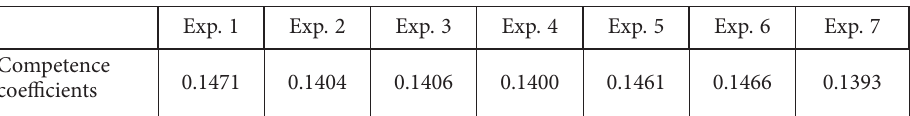
Table 4. Coefficients of experts’ competence (source: authors’